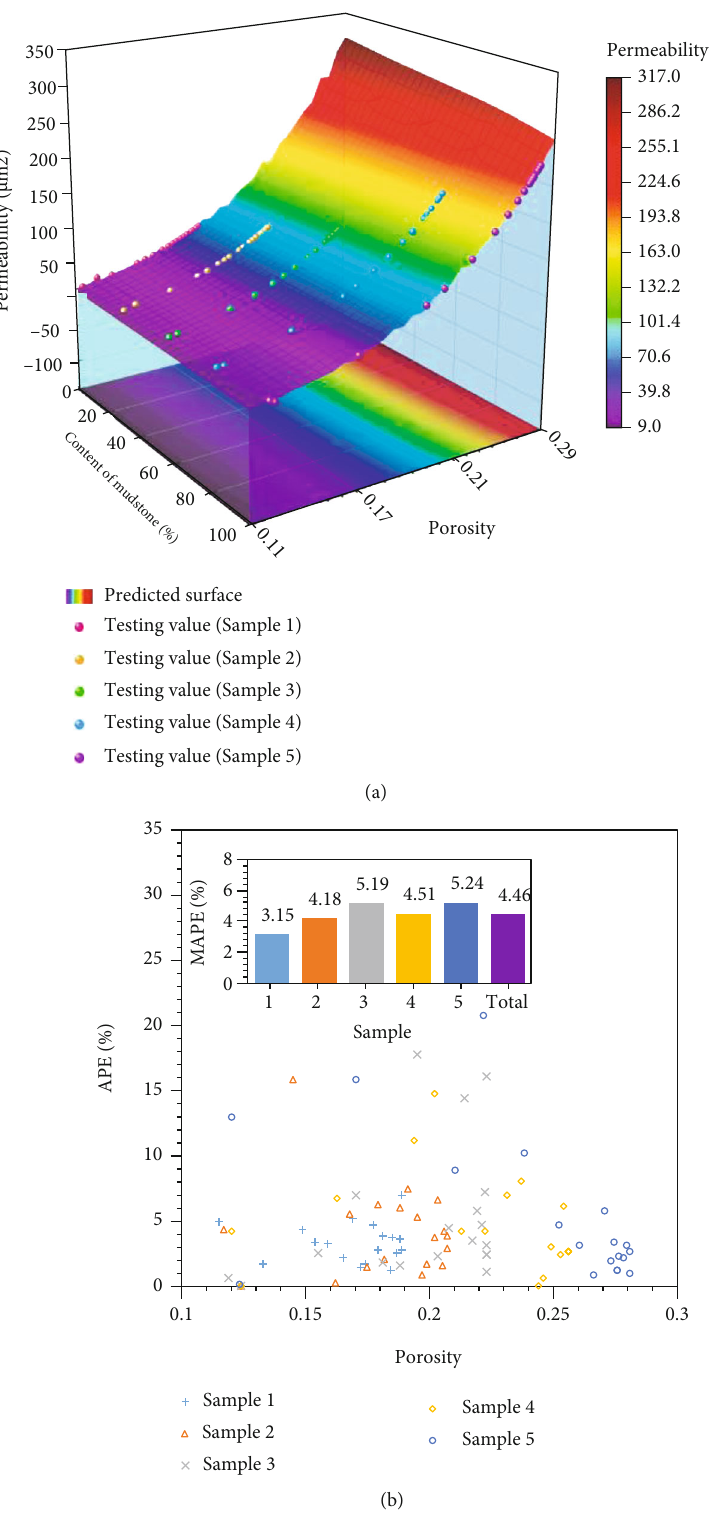
Figure 13: Comparison between testing results and predicted surface by mudstone content-based modi fi ed model (a). Comparison of results (b) APE and